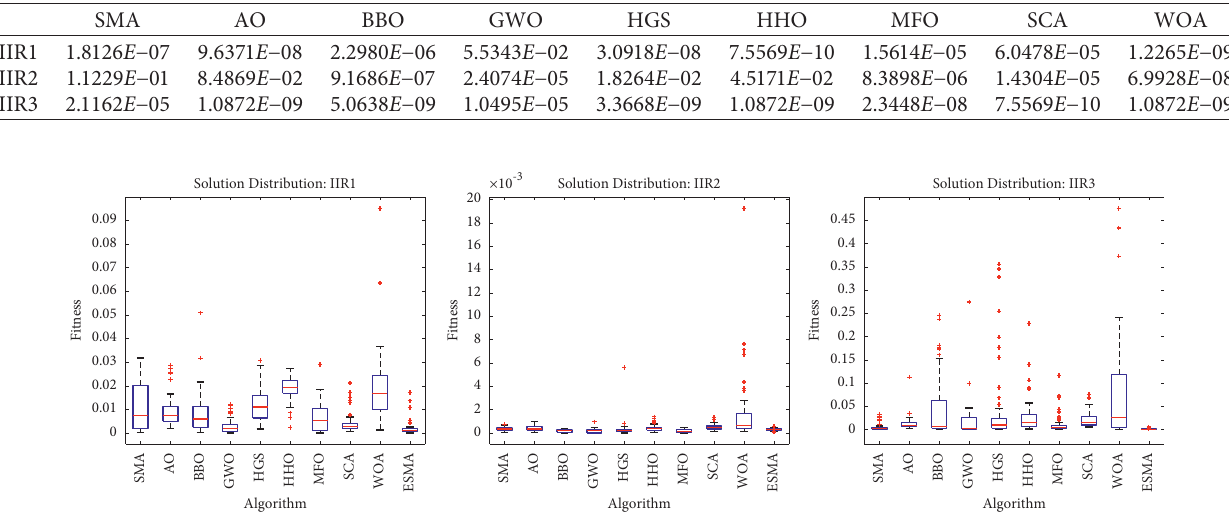
Figure 5: The distribution of the fitness of ESMA and compared algorithms on 3 IIR models.